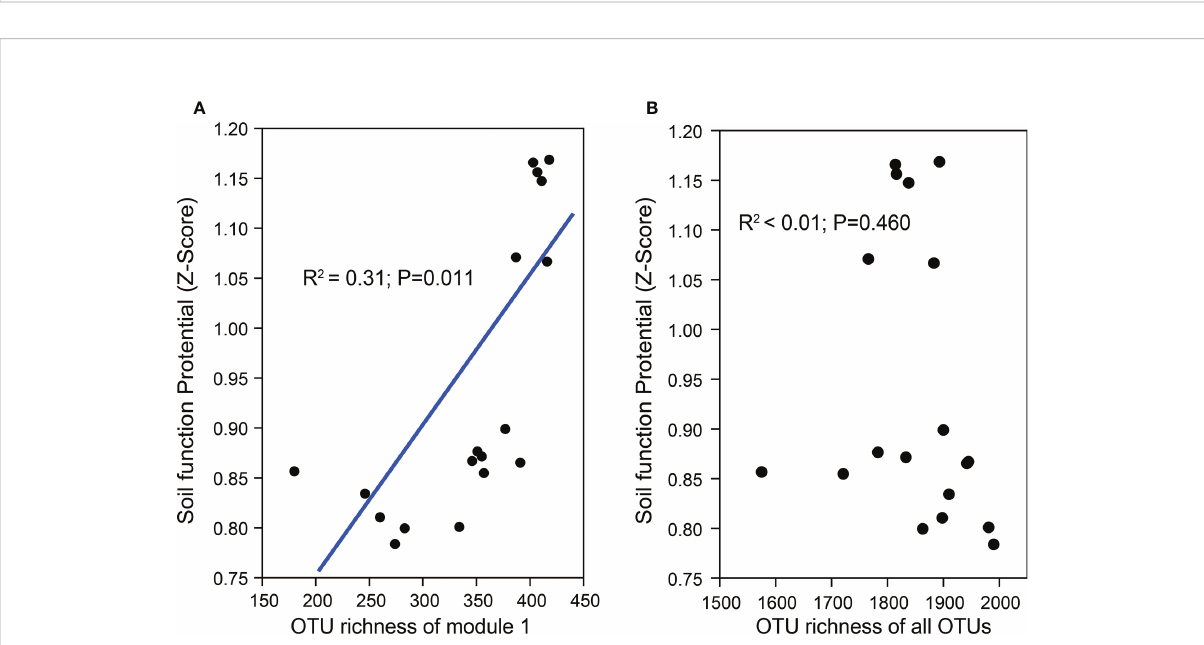
FIGURE 5 The regression relationships between the richness of the core module (Module #1) (A) , the richness of the whole community (B) , and the soil functional potentials [normalized abundance of test functional genes, RubisCO activity, PNR, and DEA